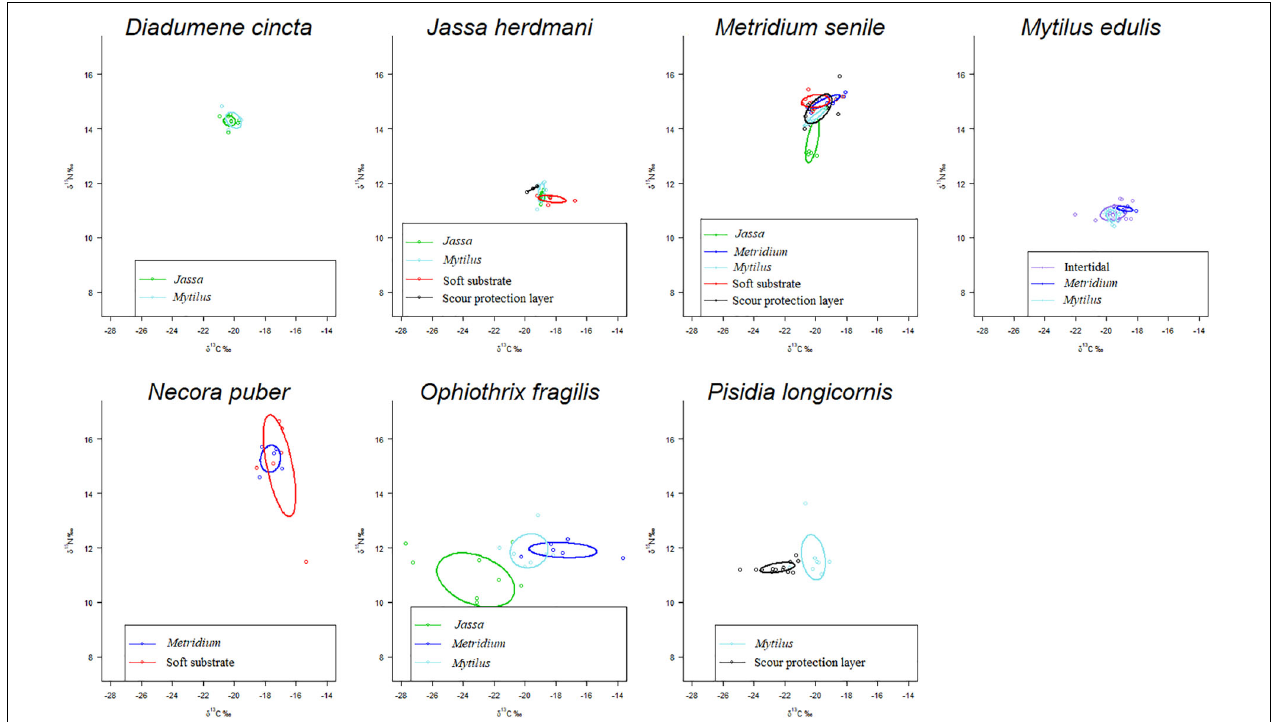
FIGURE 4 | Sample-size corrected standard ellipse areas (SEA C ) calculated from δ 13 C and δ 15 N values for the seven species under study collected from the different zones. The SEA C include the 40% of the data. The different colors represent different